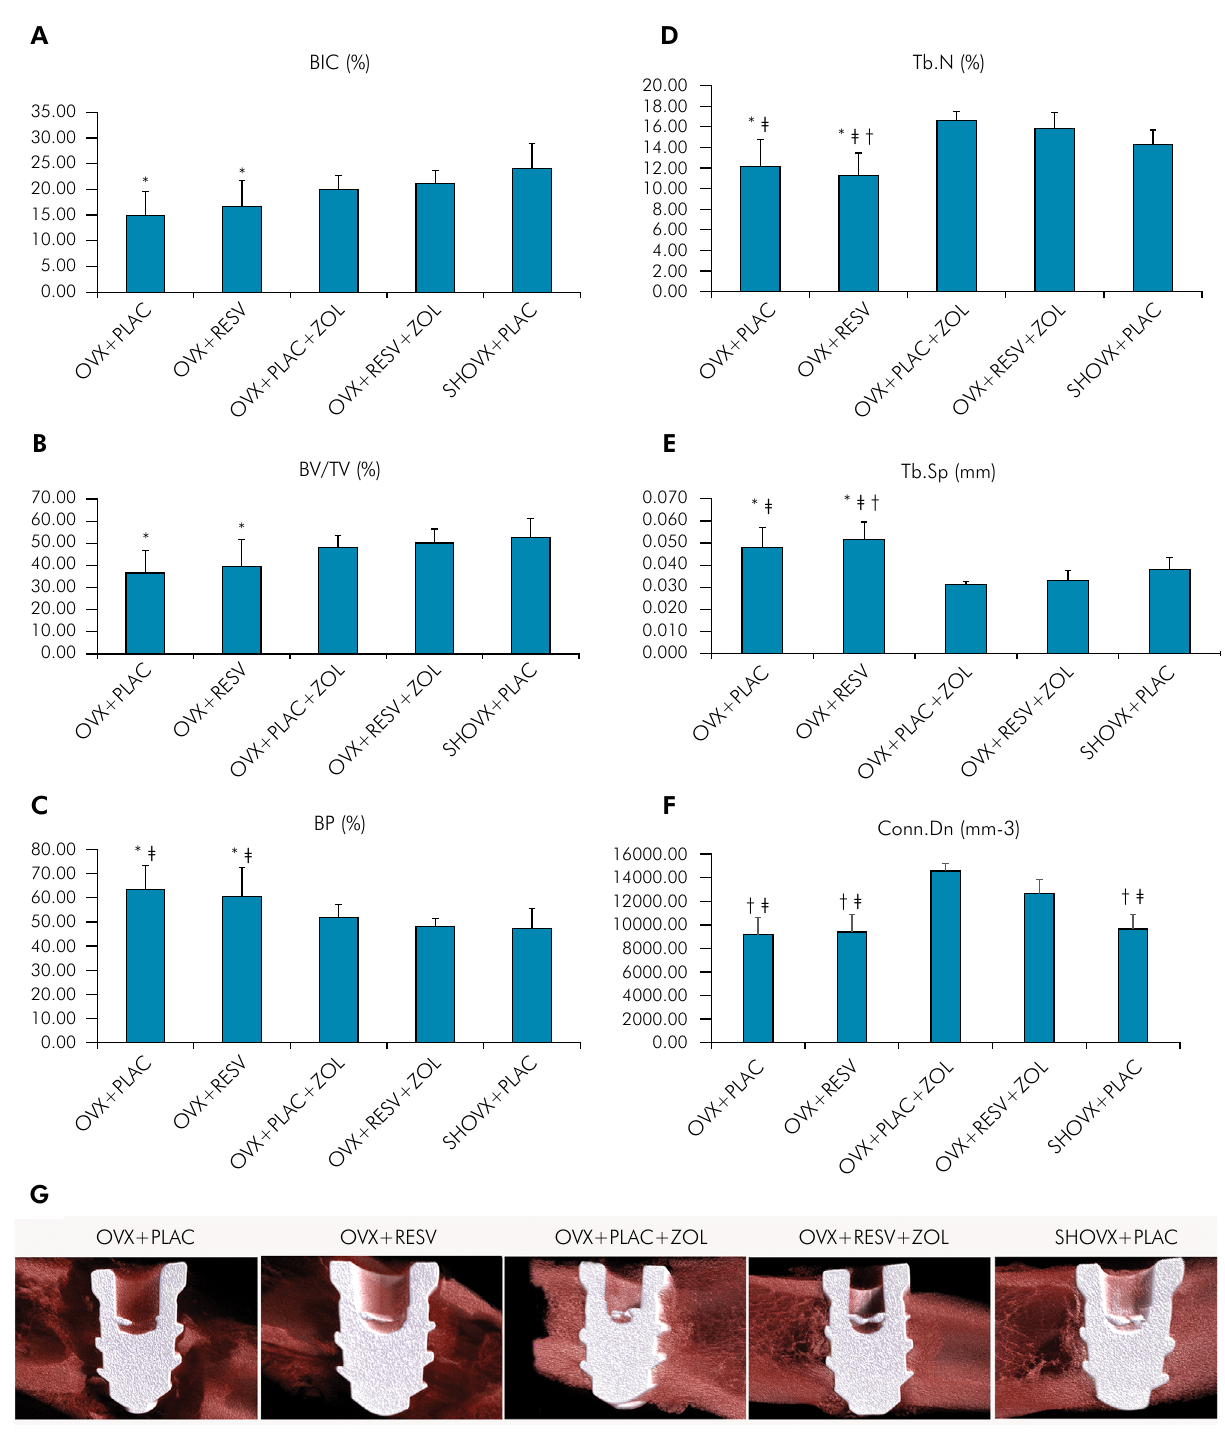
BIC: bone-implant contact; BV/TV: bone volume fraction; BP: bone porosity; Tb.N: trabecular number; Tb.Sp: trabecular spacing; Conn. Dn: connectivity density; *Significant difference compared to SHOVX+PLAC (Anova/Tukey; p<0.05); ǂ Significant difference compared to OVX+RESV+ZOL (ANOVA/Tukey, p<0.05); † Significant difference compared to OVX+PLAC+ZOL (ANOVA/Tukey, p<0.05). Figure 3. Means and standard deviations of micro-CT analysis of all groups (A-E). Representative three-dimensional rendered images of bone repair around the implant in all experimental groups